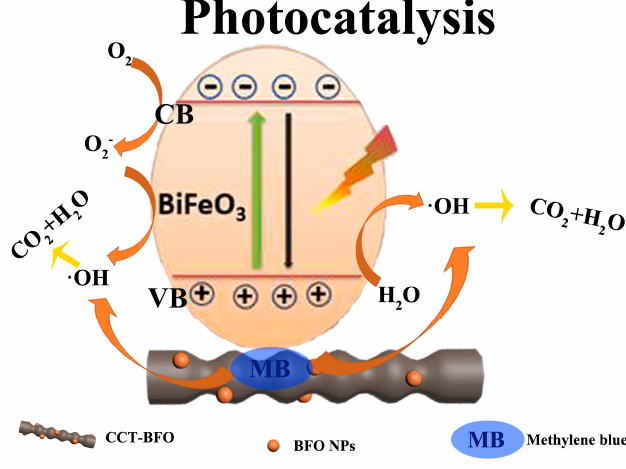
Figure 12. The schematic about the mechanism of regeneration of CCT-BFO through photocatalytic degrading MB molecules by light-irradiating the BiFeO 3 nanoparticles coated on carbon fibers’